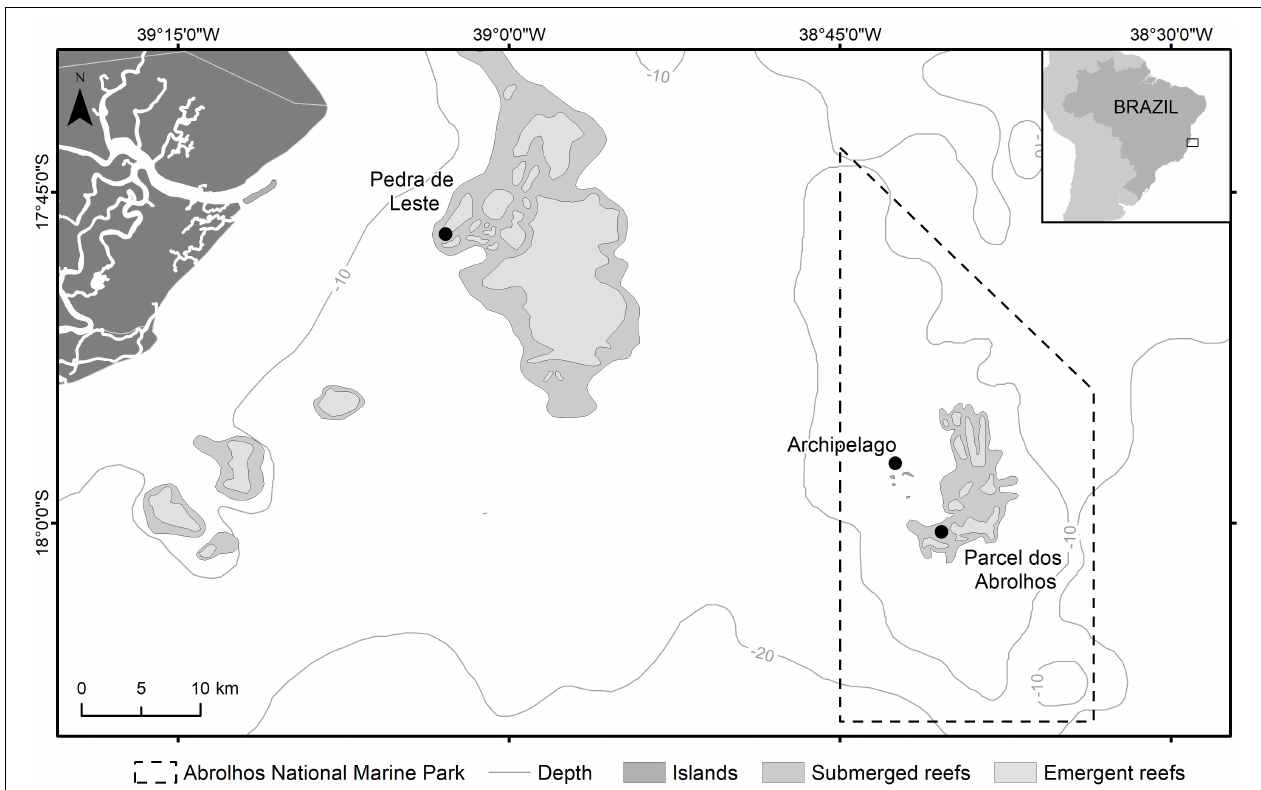
FIGURE 1 | Study area. Symbols refer to Pedra de Leste Reef (PLES), Parcel dos Abrolhos Reef (PAB), and Abrolhos Archipelago. Dashed line = Abrolhos National Marine Park.